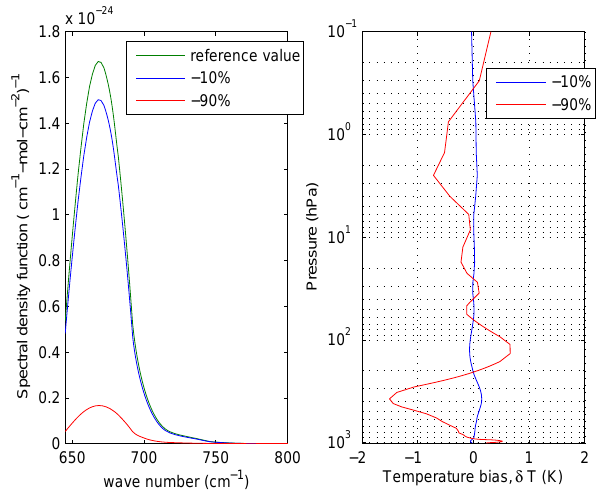
Fig. 17. Sensitivity analysis to the CO 2 continuum absorption. Panel (a) shows the spectral density function we have used as a reference (green curve) in our calculations along with the values of the same density function scaled down by 10% 90% respectively. Panel (b) shows the response in terms of temperature bias to a per- turbation equal to the reference-scaled